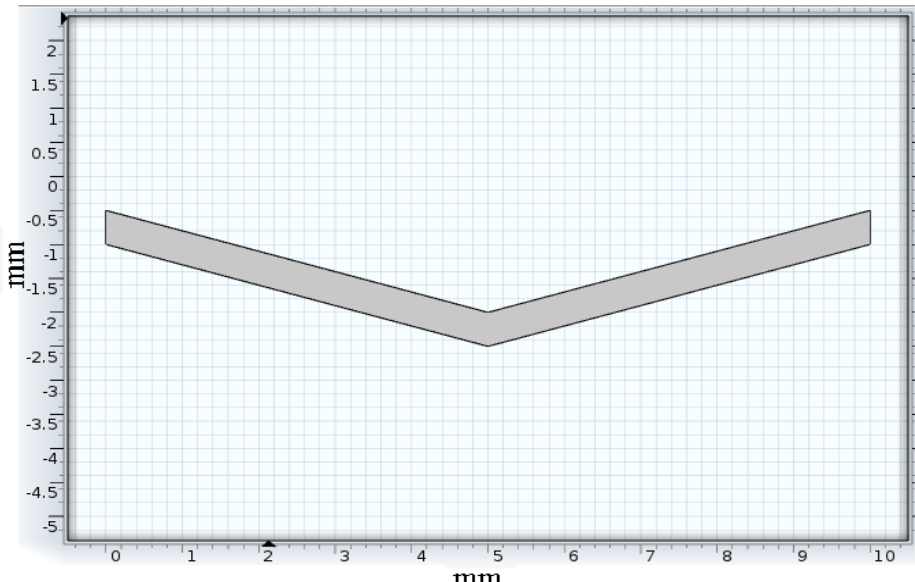
Figure 3. Tracing model.